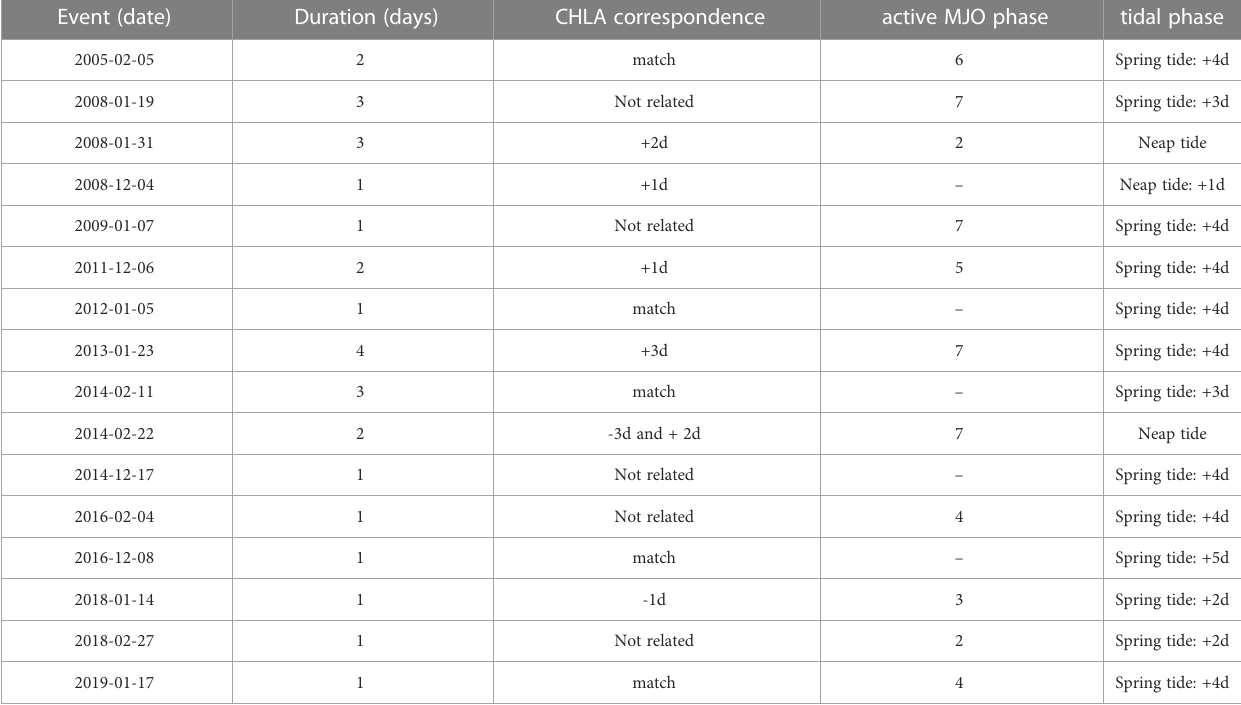
TABLE 2 Events of high phytoplankton biomass (HBEs): dates of the corresponding day 0, duration (days with spatially averaged nFLH ’ above the 95th percentile), correspondence and lag/lead of HBE with respect to CHLA ’ events (i.e., days with spatially averaged CHLA ’ above its own 95th percentile), corresponding active MJO phase, tidal phase for